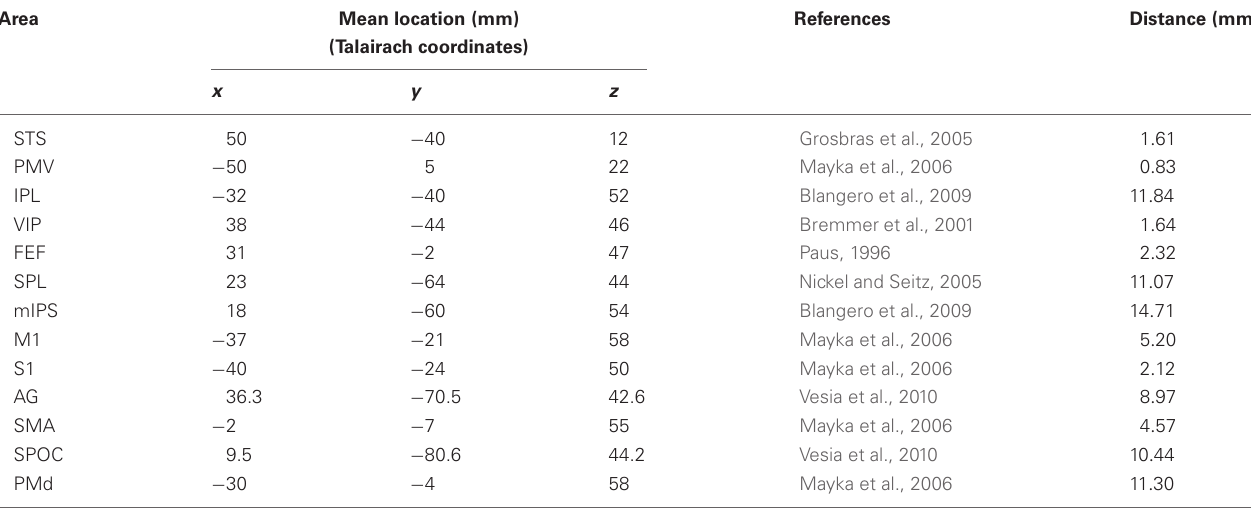
Table 4 | Mean locations in Talairach coordinates that are reported in the